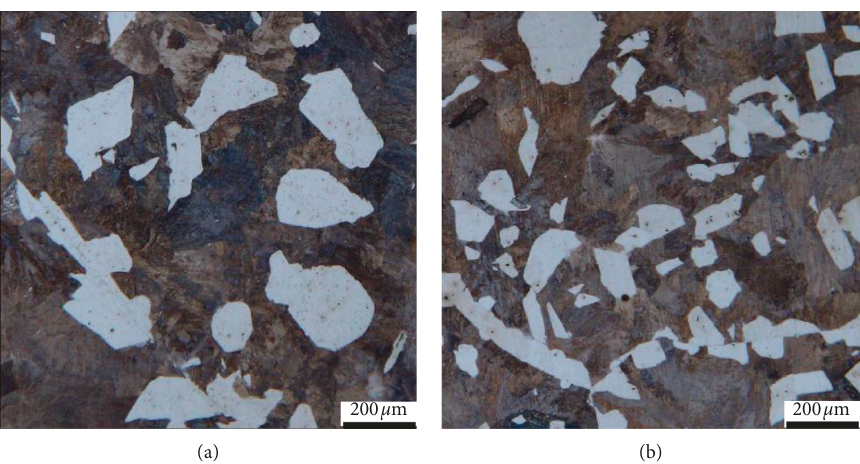
Figure 8: As-cast structures of the conventional ingot (a) and the ultrasonic ingot (b).